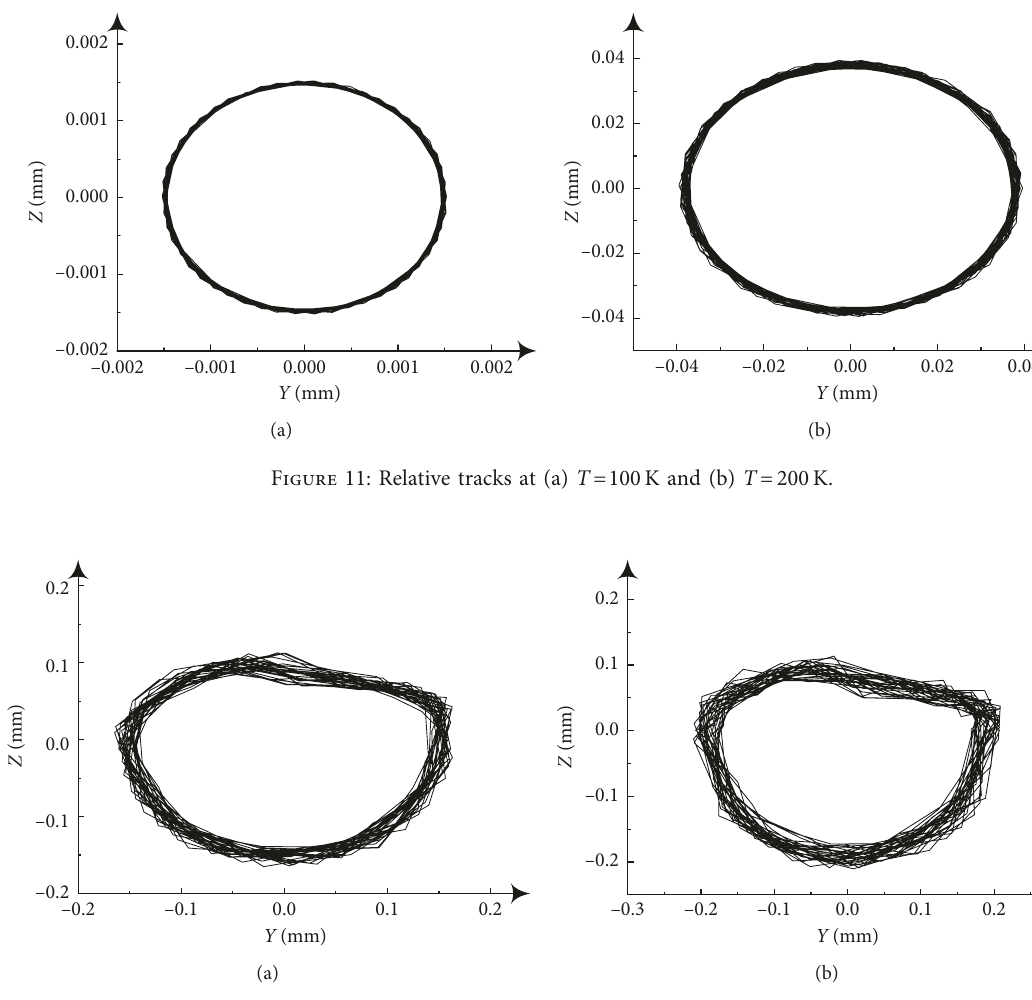
Figure 12: Relative tracks at (a) T � 500K and (b) T �